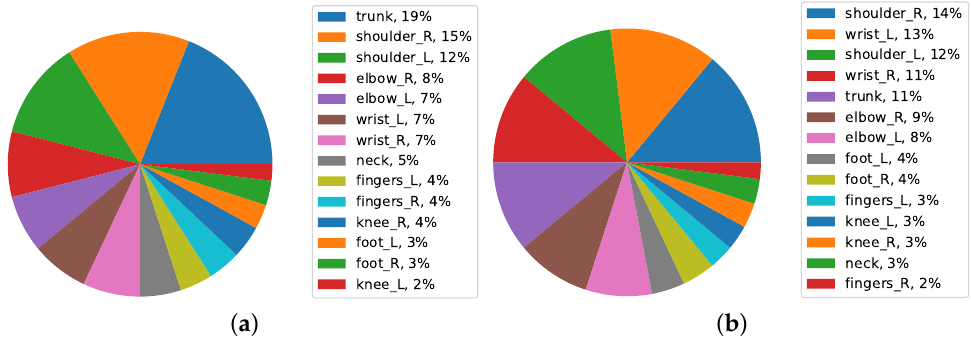
Figure 11. Average FWA of body parts in men ( a ) and ( b ) women data.